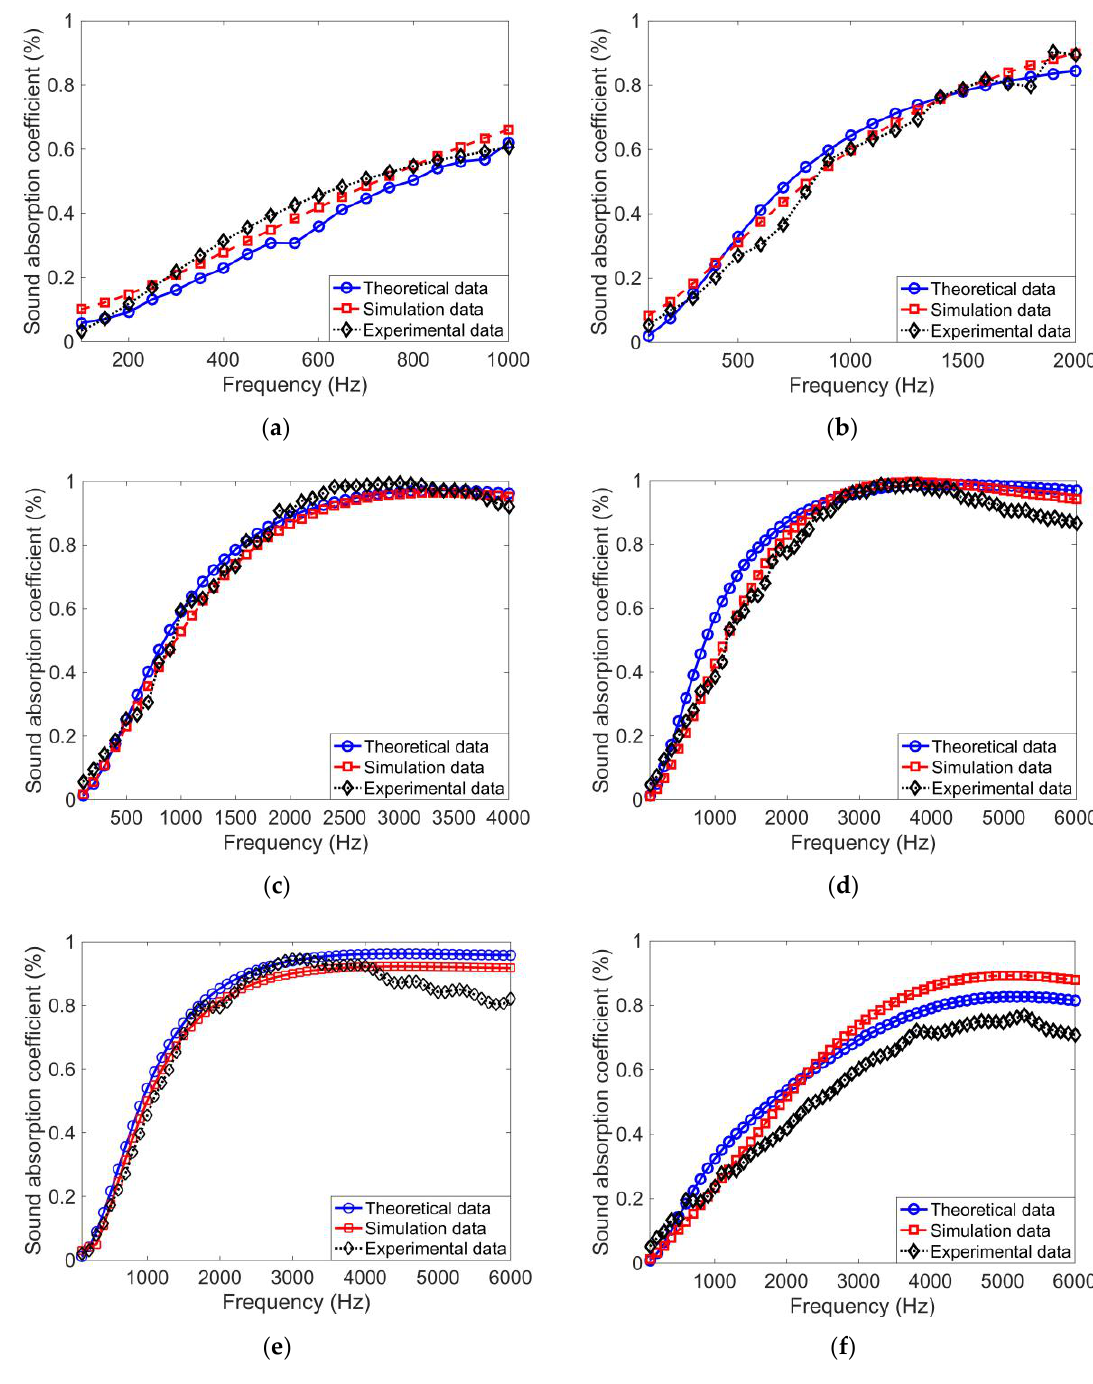
Figure 8. Comparisons of the theoretical data, the simulation data, and the experimental data of the sound absorption coefficient of the investigated sound absorbers. ( a ) Optimal 10-layer gradient compressed porous metals for 100–1000 Hz; ( b ) optimal 10-layer gradient compressed porous metals for 100–2000 Hz; ( c ) optimal 10-layer gradient compressed porous metals for 100–4000 Hz; ( d ) optimal 10-layer gradient compressed porous metals for 100–6000 Hz; ( e ) uniform compressed porous metal with the thickness of 20 mm; ( f ) original porous metal with the thickness of 20 mm.